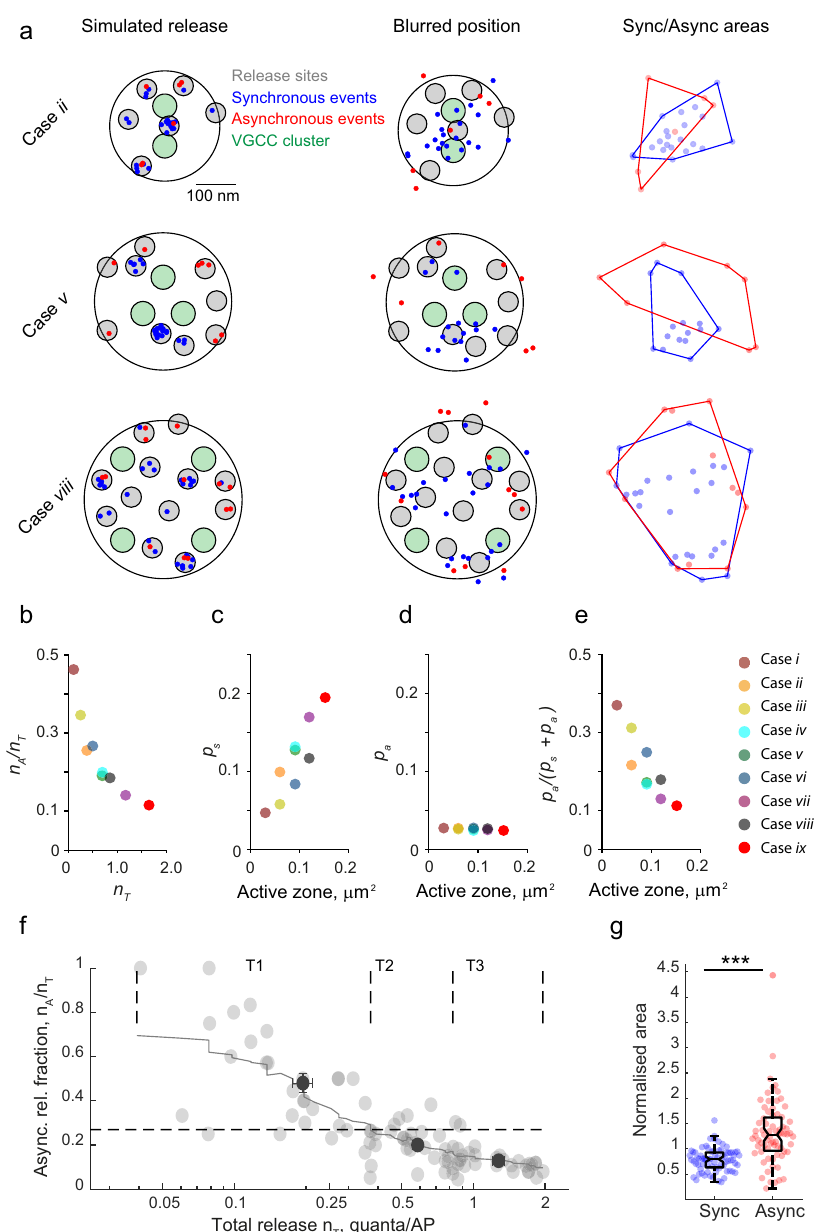
Fig. 8 Simulations of vesicular release in synapses with different active zone geometries (model with endogenous buffers). a Results of three representative simulations for active zone geometry cases ii , v and viii . Left, Simulated release. Grey circles depict randomly assigned locations of vesicular release sites. Blue and red dots correspond to synchronous and asynchronous release events respectively, which occurred during a simulated train of 51 action potentials. Middle, Blurred position. To mimic the experimental data, multi-vesicular release events were excluded and locations of the remaining events were blurred by adding a random value corresponding to the accuracy of SF-iGluSnFR event localisation (75 nm). Right, Sync/async areas. Comparison of convex hull areas circumventing simulated blurred locations of synchronous or asynchronous events. b – e Relationships between computed functional presynaptic parameters for nine modelled active zone geometries (averages of n = 250 simulations in each case): dependency of the asynchronous release fraction n A / n T on the overall release ef fi cacy n T ( b ) and dependencies of the probability of synchronous release p s ( c ), of asynchronous release p a ( d ) and of model-predicted asynchronous release fraction p a = ð p s þ p a Þ on active zone size, calculated for single RRP vesicles. Colour codes are shown on the right. f , g Comparison of the model ’ s output to the experimental results. Combined outputs from all nine considered geometry cases ( n = 10 simulations per case) were processed using the same analysis routine as for the experimental data set. f Model-predicted relationship between asynchronous release fraction and the overall vesicular release ef fi cacy n T . Similar to analysis in Fig. 3a horizontal dashed lines depict the average fraction of asynchronous release across all simulated boutons, continuous line – moving average, black dots – average values of n T and n A / n T in each tercile (mean ± SEM). g Results of reshuf fl ing analysis (similar to Fig. 6d). Data points and box-and-whisker plots: centre, median; notch 95% con fi dence interval for median; box, 25th – 75th percentiles; whiskers, the most extreme data points not considered outliers (within 1.5 times the interquartile range from the bottom or the top of the box). *** p < 0.001, two-tailed Mann – Whitney U test (for exact p values see SourceData.xlsx fi